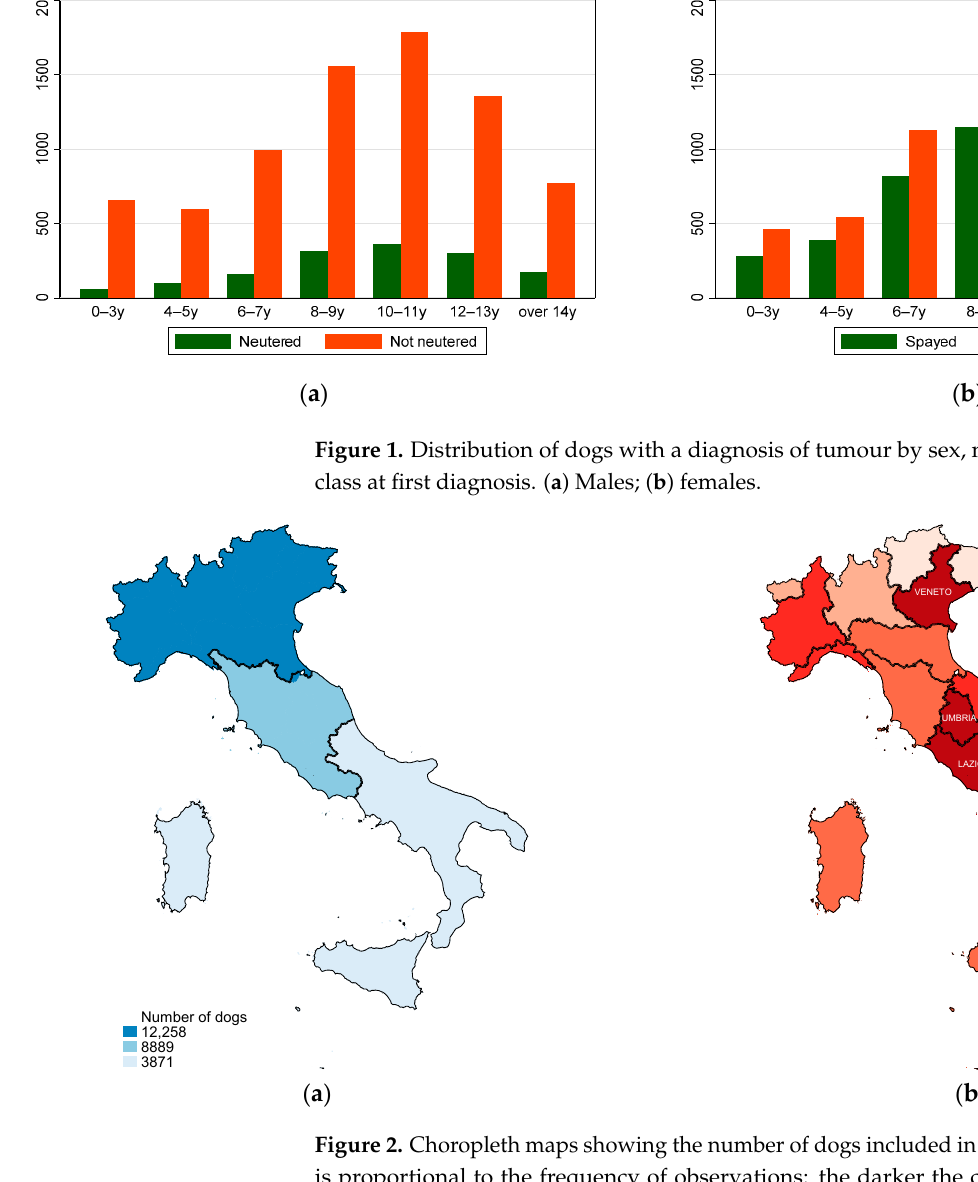
Figure 2. Choropleth maps showing the number of dogs included in the study. The gradient of colour is proportional to the frequency of observations: the darker the colour, the higher the fre- quency. ( a ) Absolute number of dogs with a diagnosis of tumour by macroregion of residency of the owner (North, Centre, South and Islands), ( b ) number of dogs with a diagnosis of tumour by Italian region, classes follow a quantile distribution, with regions grouped in 5 quintiles, with 4 Regions each. “()“ = excluded; “[]” = included.